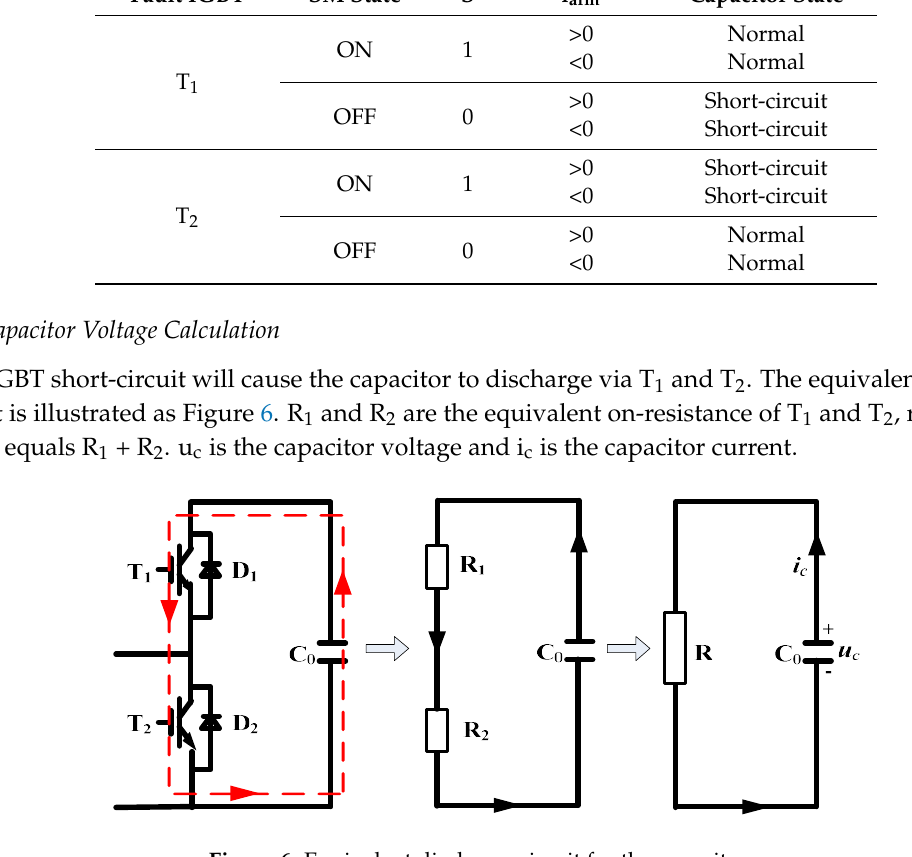
Figure 6. Equivalent discharge circuit for the capacitors.